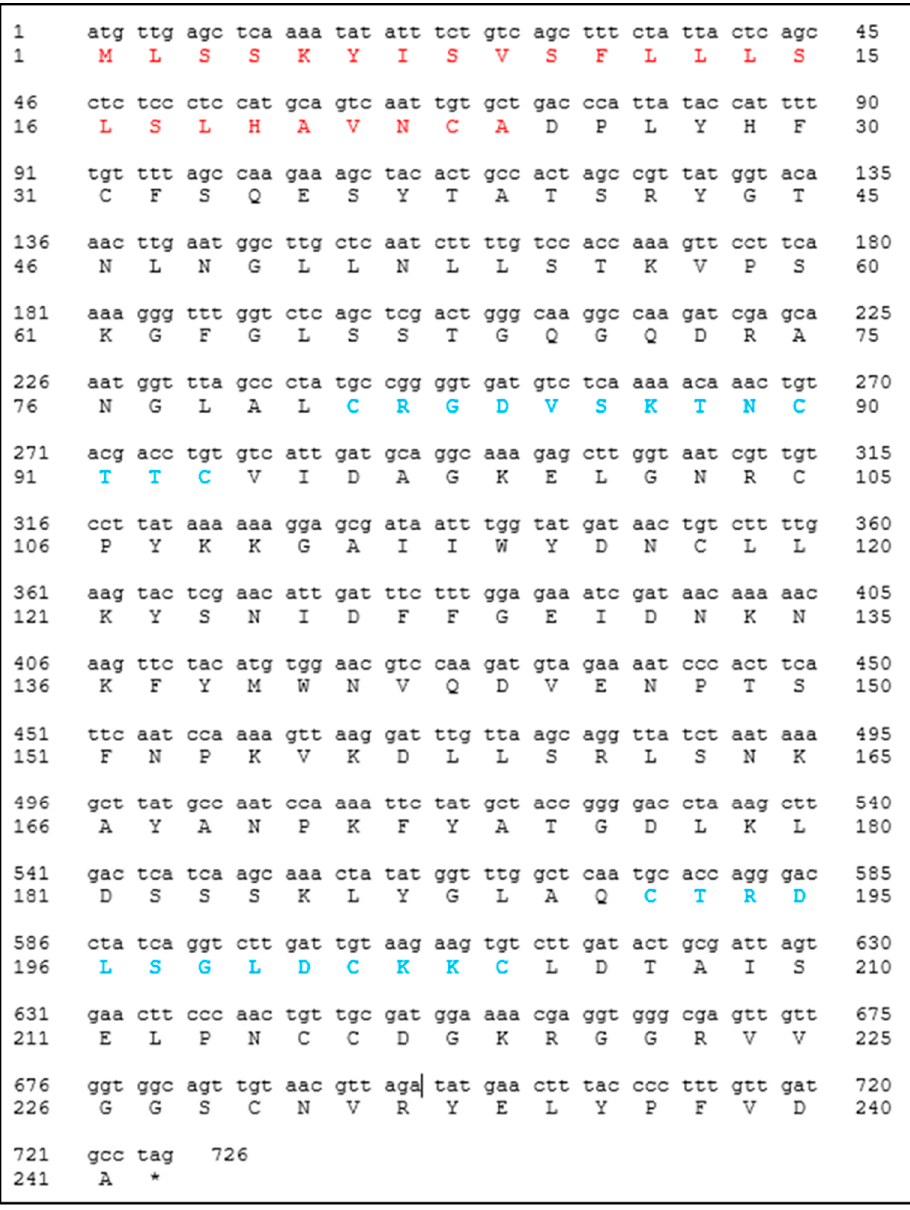
Figure 1. Sequences S1. Cast_GNK2-like coding sequence (up) and respective amino acid sequence (below). In red is the prediction of the signal peptide to the apoplast. In blue, the two conserved cysteine motifs a tt ributed to the antimicrobial action. *: stop codon.